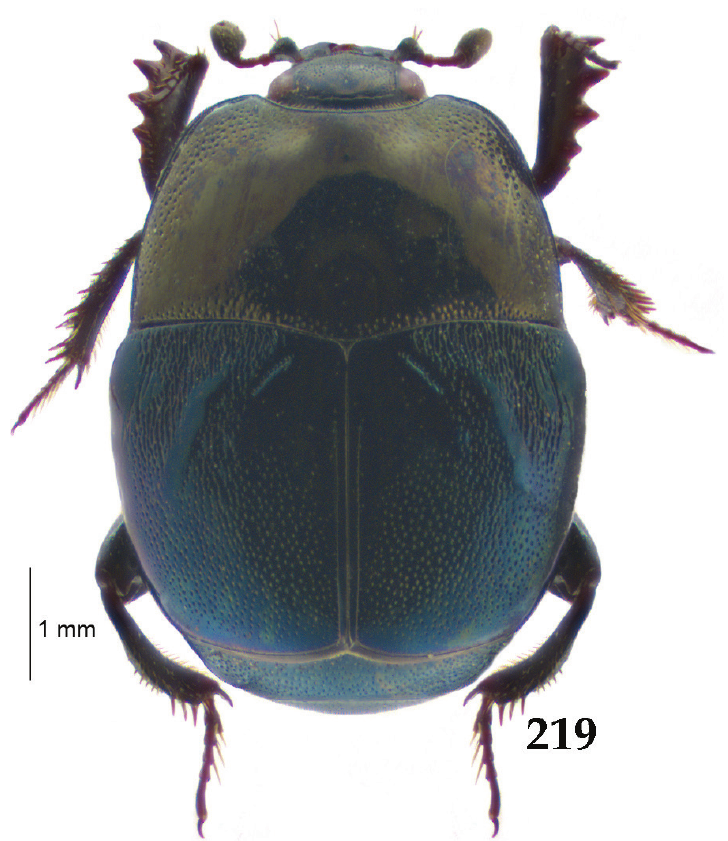
Figure 219. Notosaprinus irinus (Marseul, 1862) habitus, dorsal view. Type material examined. Saprinus irinus Marseul, 1862: Lectotype, present designa- tion: ♀ , (genitalia extracted and lost; specimen’s mounting card was pencil-marked with a female sign; probably not the original mounting card of Marseul), side-mounted, both protarsi, right mesotarsus, left metatibia and right metatarsus missing, with the following labels: “22a / Saprinus irinus m. / N. Holl. / T. Dré” (pink, round label, written); fol- lowed by one more identical label; followed by: “MUSEUM PARIS / irinus / COLL. / De MARSEUL 1890” (pink label, printed-written); followed by: “TYPE” (red-printed rectangular label); followed by: “Saprinus irinus / Marseul, 1862 / LECTOTYPE / des. T. Lackner 2014” (red label, written) (MNHN). This species has been described from an un- known number of specimens and the lectotype designation fixes the identity of the species. Additional material examined. AUSTRALIA. New South Wales: 3 ♀♀ , Rich- mond River, 1909, collector unknown (BMNH); 2 ♂♂ , Richmond River, without further data, Coll Van de Poll (MNHN); 1 ♀ , Gerroa, 29.xii.1974, H. & A. Howden (MNHN); 1 ♀ , Sydney, without further data (MNHN); 2 specs., N.S. Wales, without further data (MNHN); 1 spec., Chichester S.F., Allyn River, 32.08S 151.27E, T.